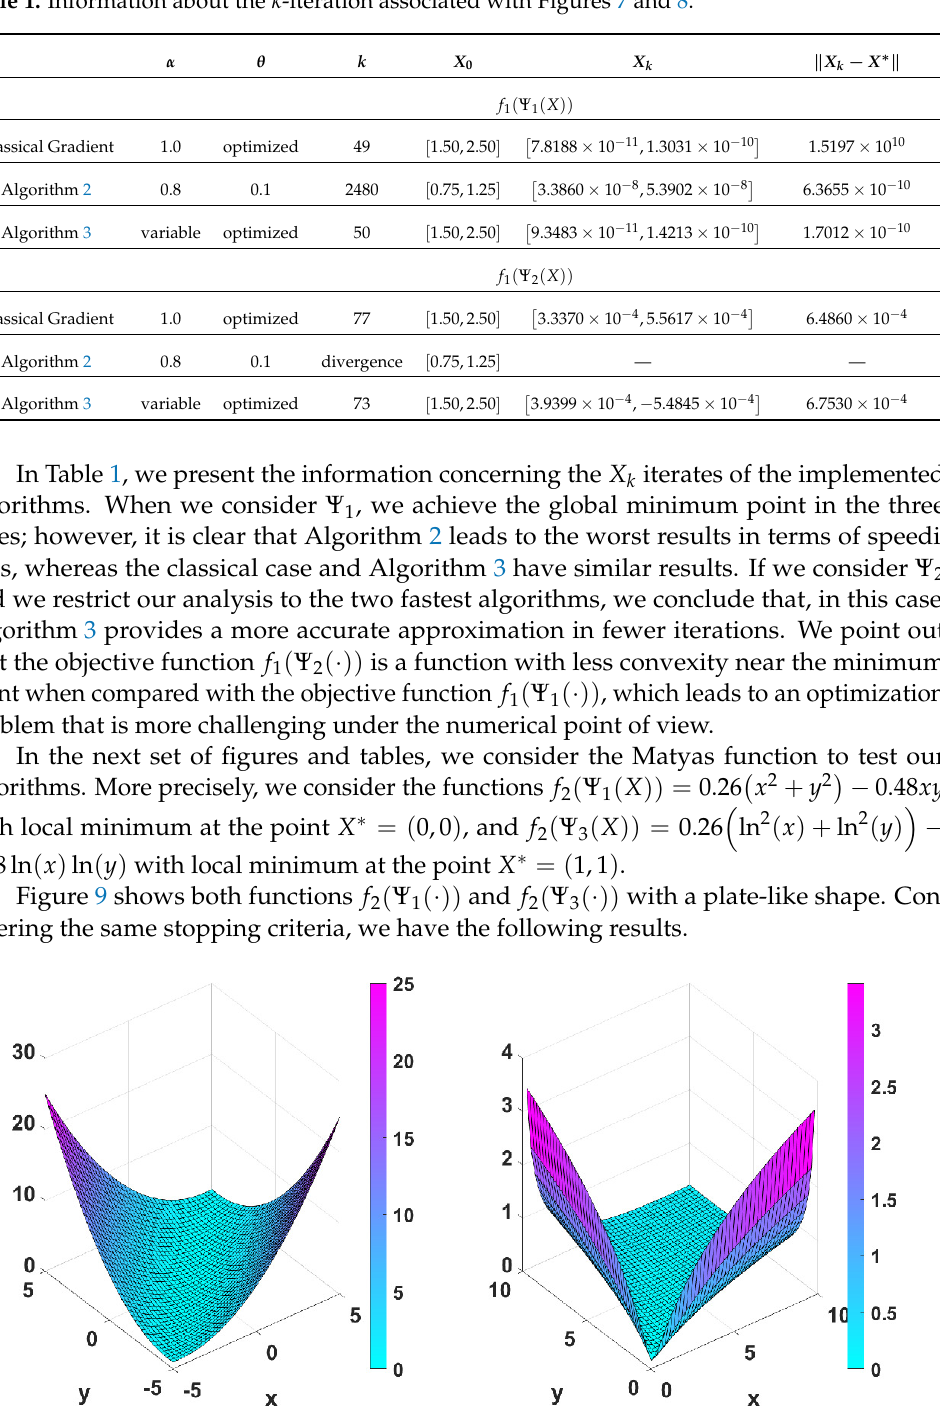
Figure 9. Graphical representations of f 2 ( Ψ 1 ( X )) and f 2 ( Ψ 3 ( X ))